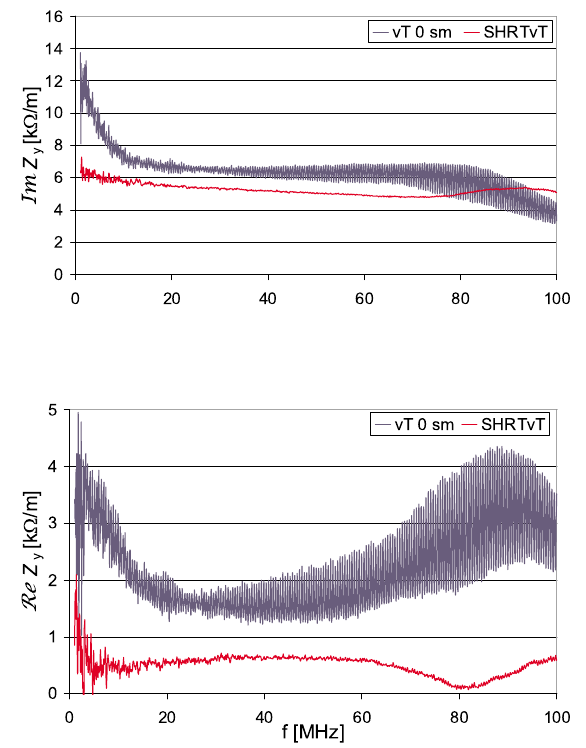
FIG. 24. (Color) Vertical impedance of kicker system with magnet